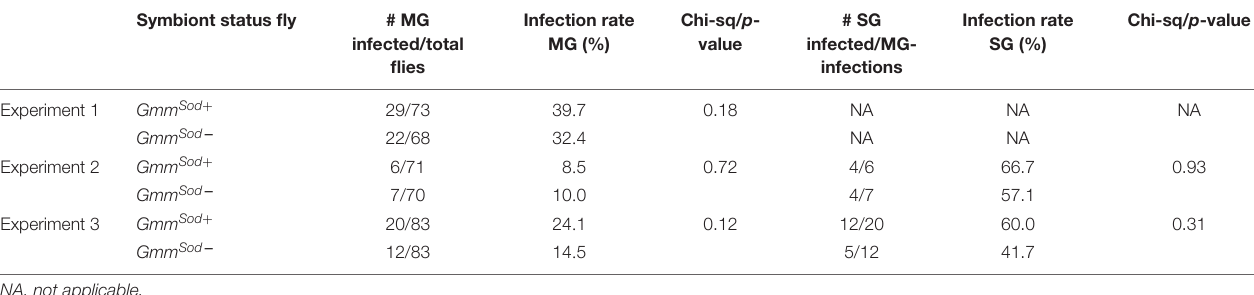
TABLE 1 | Trypanosome infection outcome in tsetse fly midguts (MG) and salivary glands (SG) of symbiotic ( Gmm Sod + ) and S. glossinidius -free ( Gmm Sod − ) flies that were given a Trypanosoma brucei brucei -parasitized blood meal when they were newly emerged, 1 day post-eclosion.